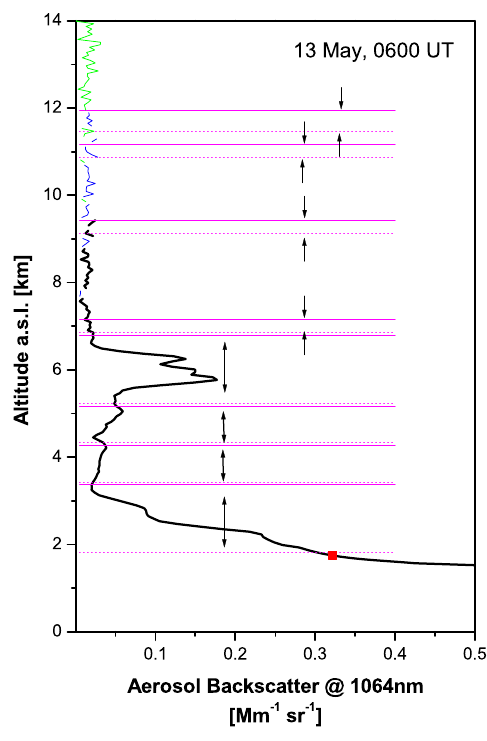
Fig. 2. Example of single profile particle layer identification as per- formed on the aerosol backscatter profile at 1064nm measured on 13 May, at 05:30–06:30UTC. Horizontal dotted and solid lines in- dicate the base and top of the identified layers, respectively. The red square indicates the top of the PBL. Region with relative errors between 30% and 50% are reported in blue and those with relative error exceeding 50% in